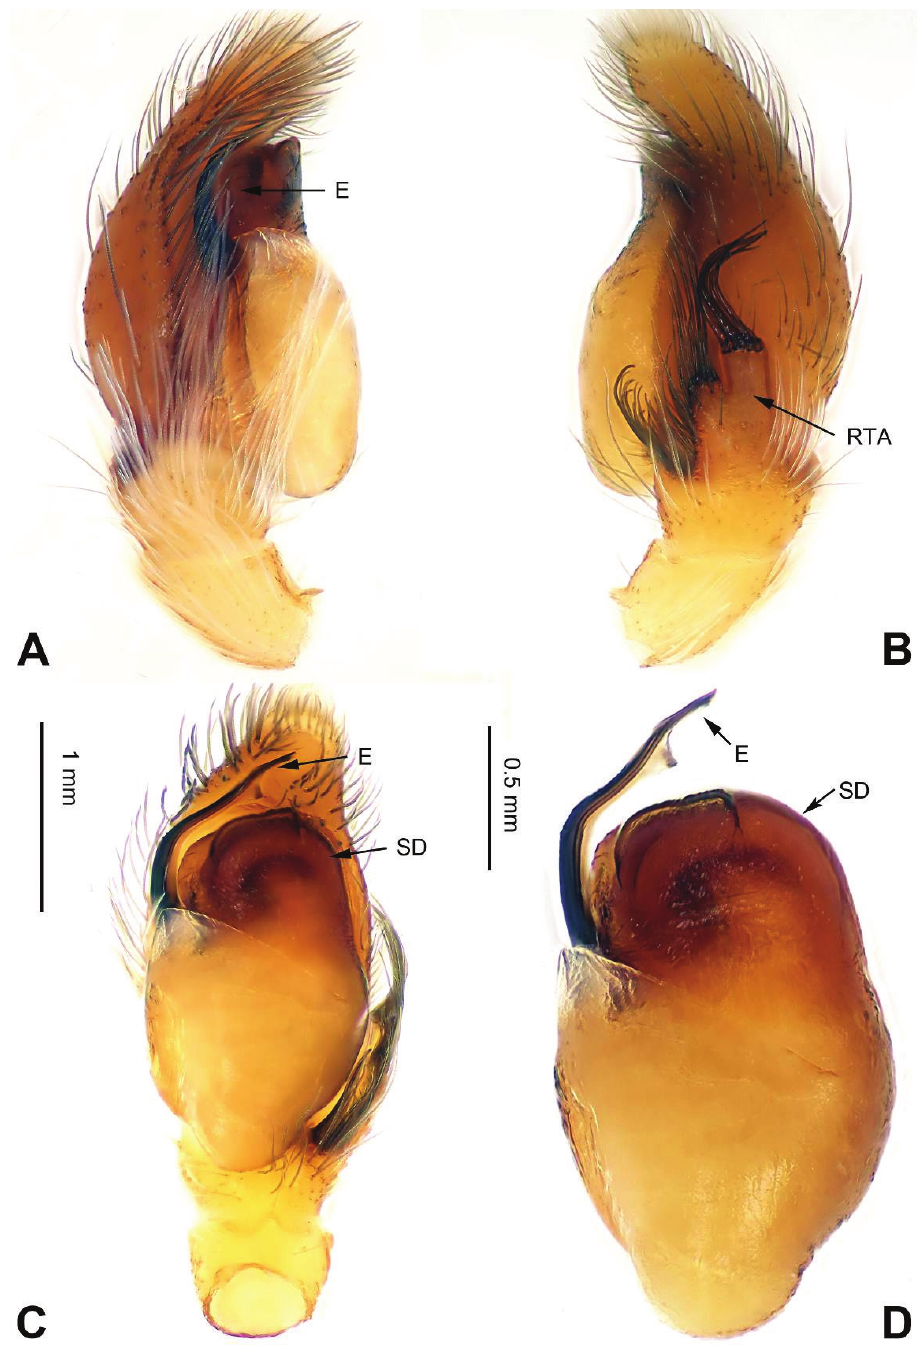
Figure 23. Palp of Gedea pinguis sp. n., male holotype. A prolateral B retrolateral C ventral D bulb, ventral. Scale bar equal for A–C